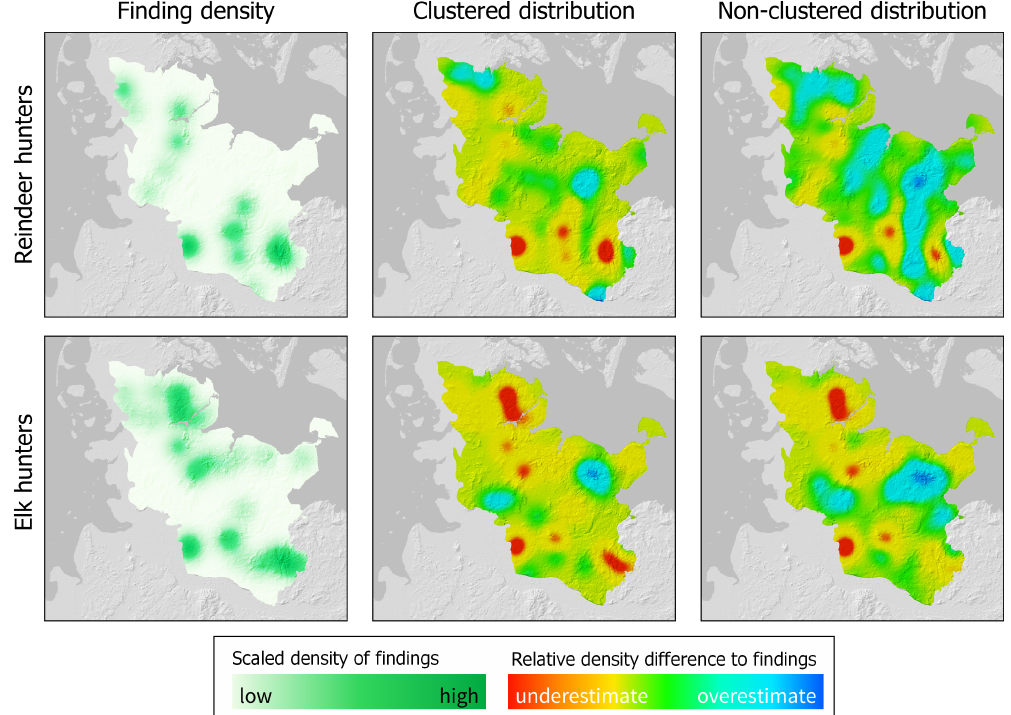
Figure 6. Difference between the density of findings and the density of point distributions. Low values (red) indicate that the observed density is higher than the simulated density, while higher values (blue) indicate a higher predicted